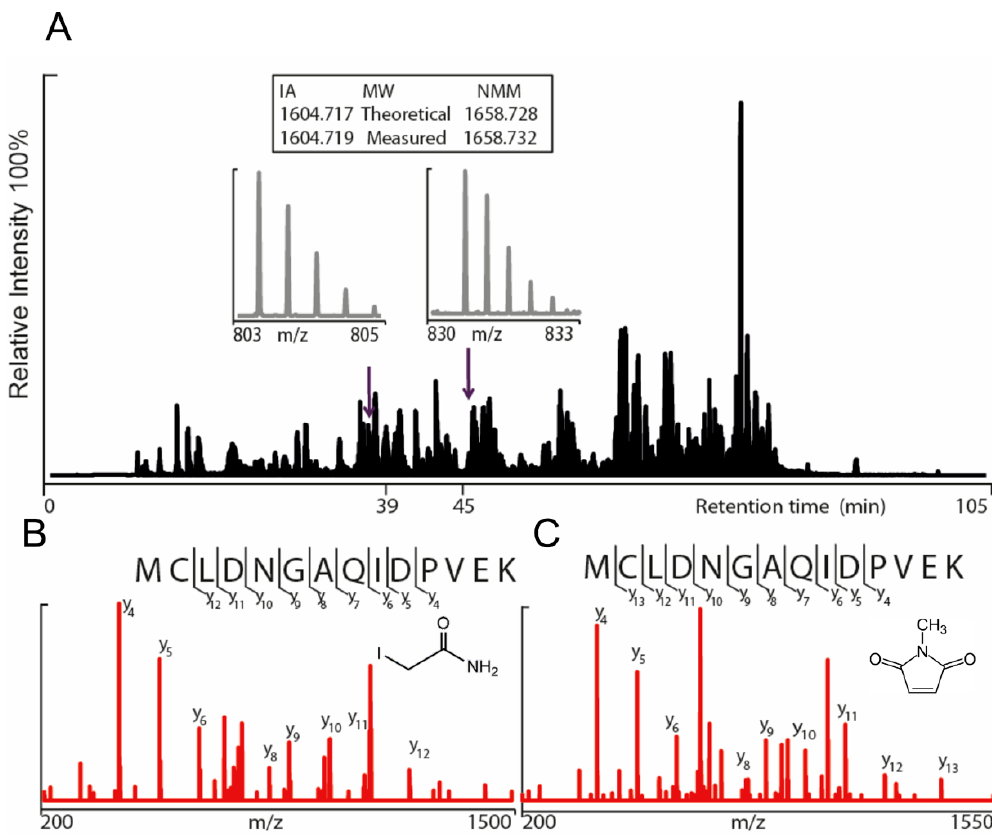
Figure 2. Annotation of iodoacetamide (IA) modified and N -methylmaleimide (NMM) modified 257–270 human TRPA1 (hTRPA1) peptides (MCLDNGAQIDPVEK) using nanoHPLC and tandem mass spectrometry. ( A ) Representative total ion chromatogram of trypsin digested hTRPA1 depicted in black. The IA and NMM modified peptides (257–270) for Cys258 were eluted at 39 min and 45 min respectively. The Orbitrap mass spectra of the double-charged Cys258-IA peptide ( m / z 803.3669) and the double-charged Cys258-NMM peptide ( m / z 830.3731) enabled accurate mass determination of both peptides (isotopic distribution depicted in grey). The assigned fragmentation pattern of IA ( B ) and NMM ( C ) modified peptides are given in red with indicated y-ions.